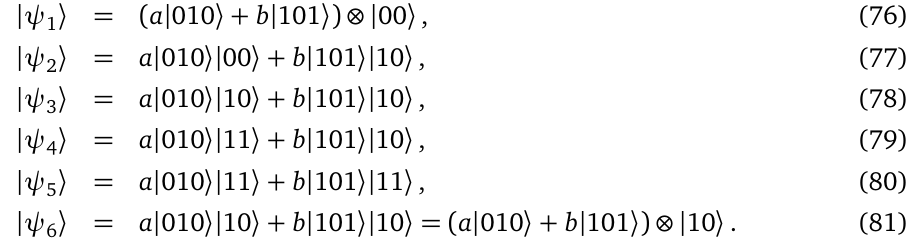
, in the state | ψ 〉 ) are effectively “voted” against 1 − 3 , both set to | 0 〉 ) at the bottom of the circuit. This 1,2